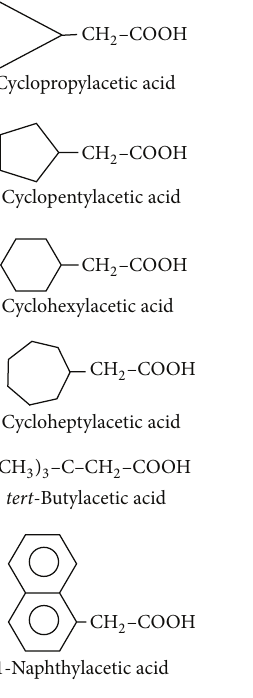
Figure 3: Structures of acetic acid